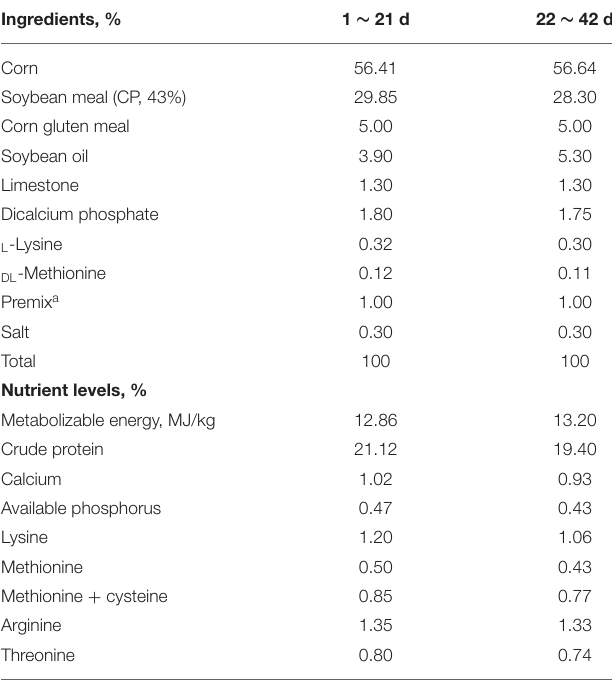
TABLE 1 | Ingredient composition and nutrient contents of basal